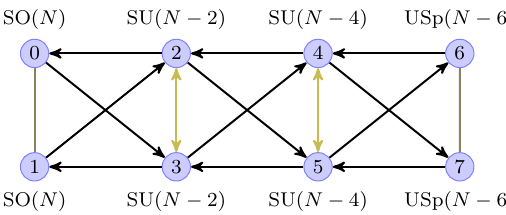
Figure 21. The quiver for the orientifold theory of L 0 , 6 , 0 / Z 2 → L 2 , 4 , 2 / Z 2 → L 3 , 3 , 3 / Z 2 in Family B with choice ( τ 0 = τ 1 = + , τ 6 = τ 7 = − ) . Colored fields represent the pairs that are mass deformed in the chain, the color match the chain of five-branes in figure